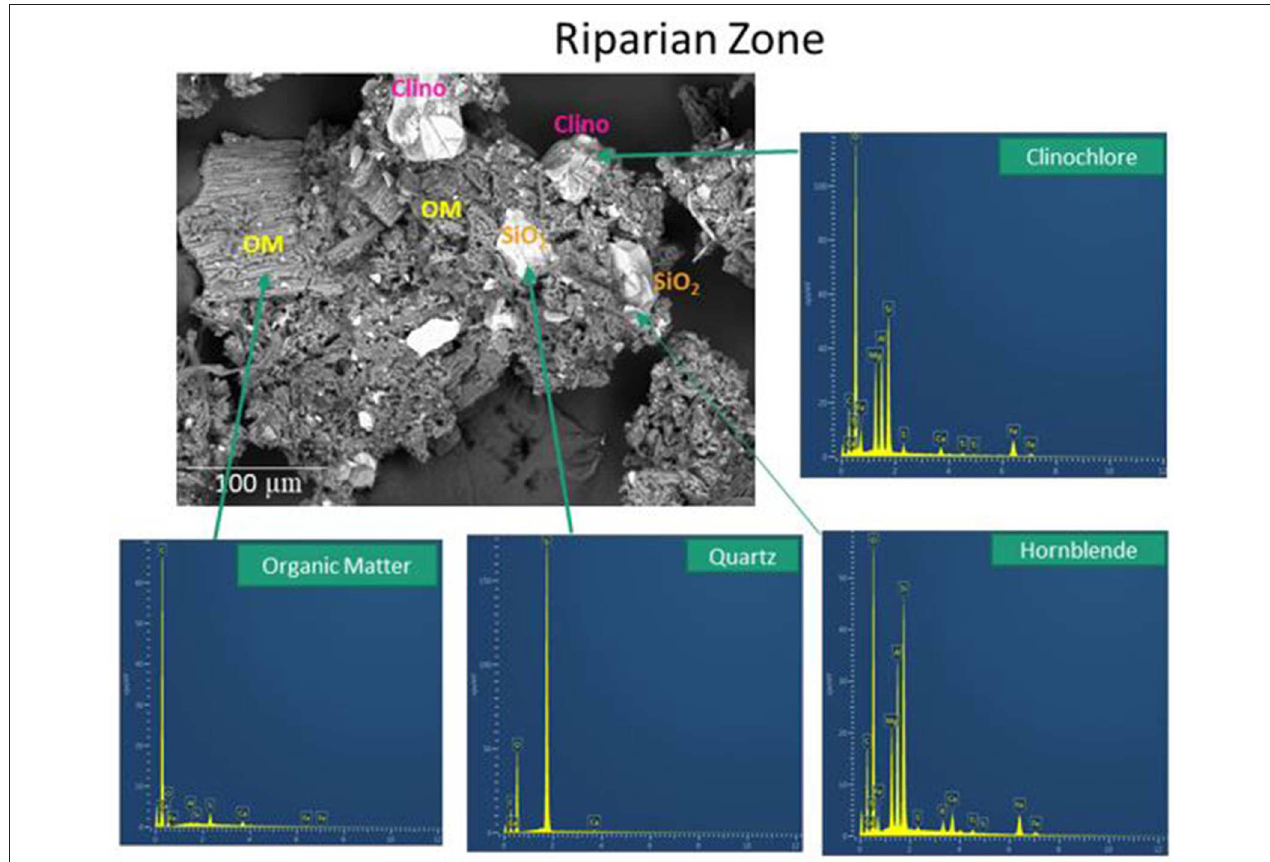
FIGURE 7 | Secondary electron scanning electron microscopy (SE SEM) image of soil aggregates present in composite soils from the riparian zone (RZ) of the high transect. OM, organic matter; clino, clinochlore.